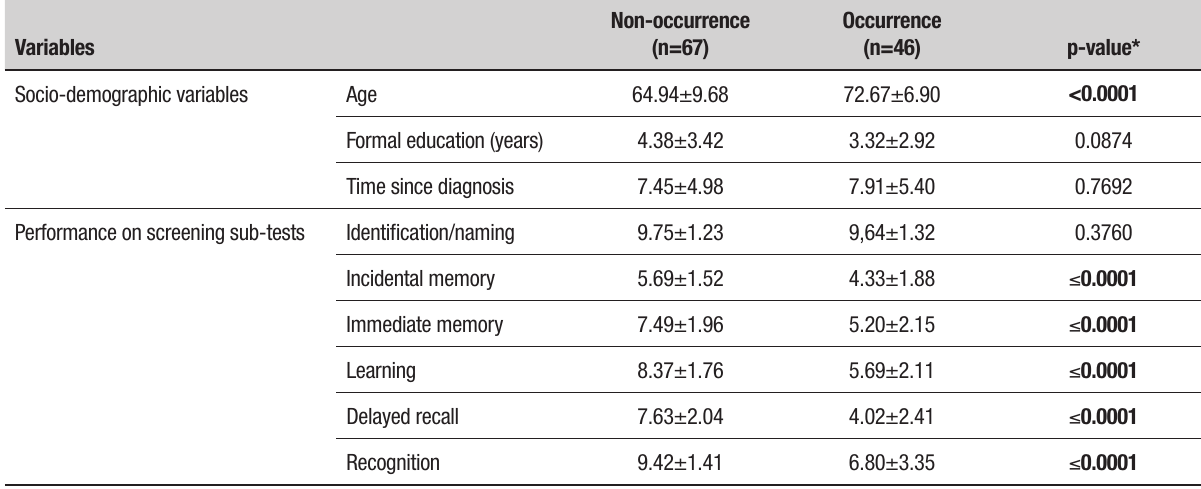
Table 2. Comparison between groups (occurrence and non-occurrence of dementia).